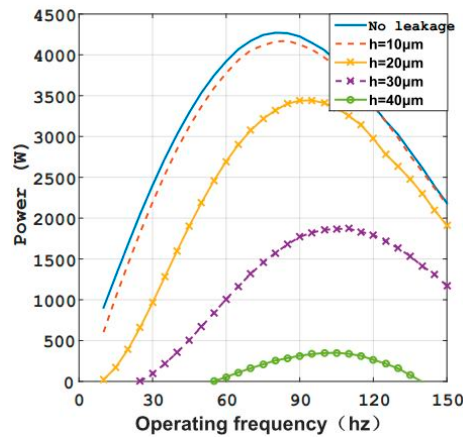
Figure 23. Engine power vs. frequency under different gap heights.